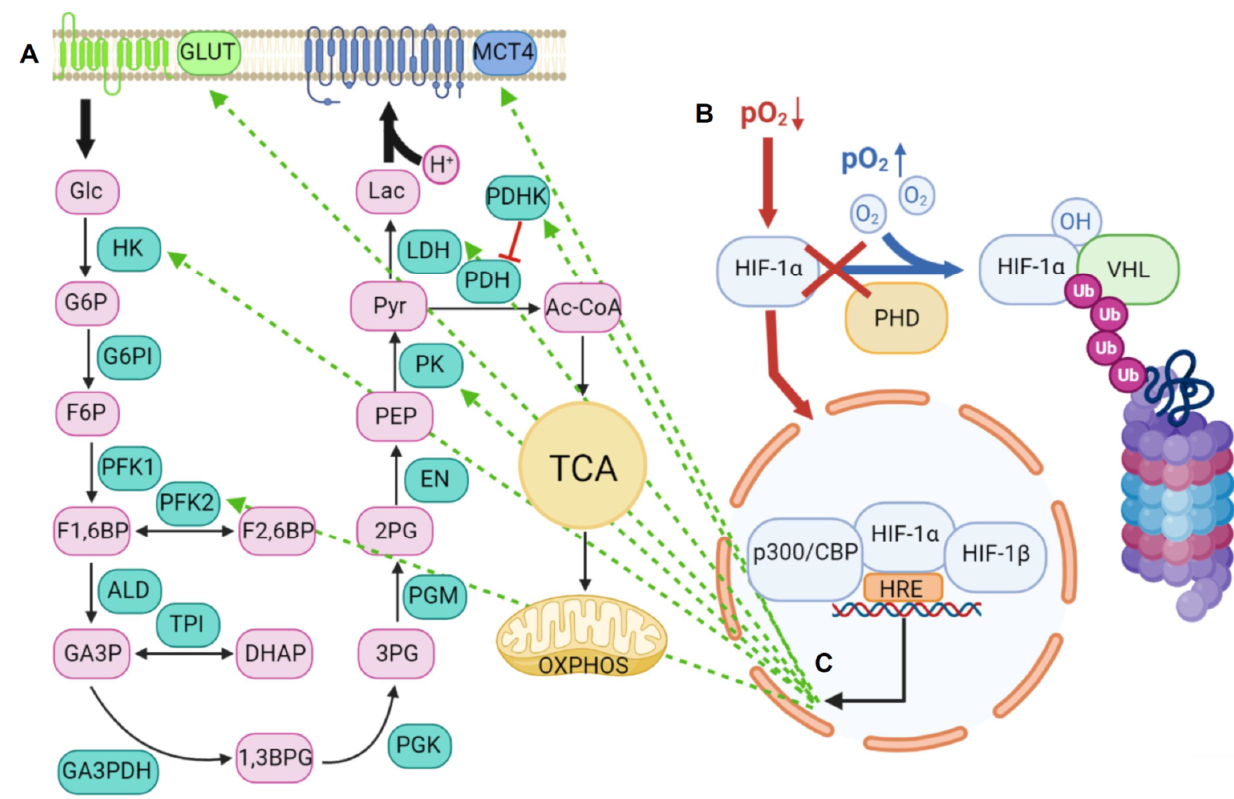
Figure 1. The glycolytic switch under hypoxia. ( A ) Scheme of glycolysis. Glucose (Glc) is taken up via GLUTs and enters glycolysis. The product pyruvate (Pyr) enters the TCA cycle and OXPHOS by conversion to acetyl coenzyme A (Ac-CoA) in oxidative cells or is converted to lactate (Lac) under anaerobic conditions in glycolytic cells. Lactic acid is exported by MCT4. ( B ) Regulation of HIF-1α. Under normoxia, HIF-1α is hydroxylated by PHDs and ubiquitinylated (Ub) by VHL complex for proteasomal degradation. Under hypoxia, HIF-1α migrates into the nucleus and activates transcription of multiple genes by binding to HREs in a complex with HIF-1β and p300/CBP. ( C ) Regulation of the glycolytic switch by HIF-1α. Under hypoxia, HIF-1α induces GLUTs, MCT4, and different glycolytic enzymes, which direct glucose consump- tion into anaerobic glycolysis. G6P: glucose-6-phosphate, F6P: fructose-6-phosphate, F1,6BP: fructose-1,6-bisphosphate, F2,6BP: fructose-2,6-bisphosphate, GA3P: glycerin-aldehyde-3-phosphate, DHAP: di-hydroxy-acetone–phosphate, 1,3BPG: 1,3-bis-phosphoglycerate, 3PG: 3-phospho-glycerate, 2PG: 2-phospho-glycerate, PEP: phospho-enol-pyruvate, HK: hexokinase, G6PI: glucose-6-phosphate-isomerase, PFK1/2: phospho-fructokinase 1/2, ALD: aldolase, TPI: triose- phosphate-isomerase, GA3PDH: glycerin-aldehyde-3-phosphate-dehydrogenase, PGK: phospho-glycerate-kinase, PGM: phospho-glycerate-mutase, EN: enolase, PK: pyruvate-kinase, PDH: pyruvate-dehydrogenase, PDHK: pyruvate-dehydro- genase-kinase.